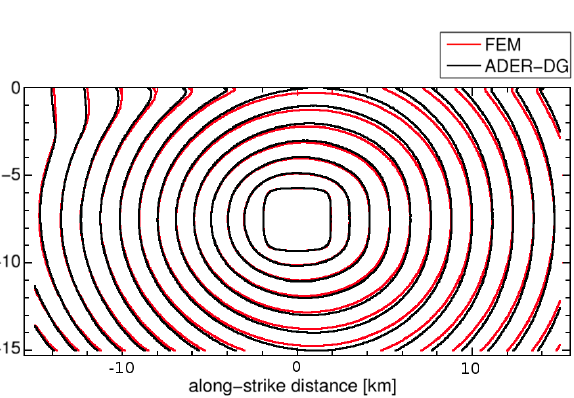
Fig. 12. Rupture front every 0.5s in problem TPV6 with bimate- rial interface. The ADER-DG solution is shown in black, the FEM comparison solution in